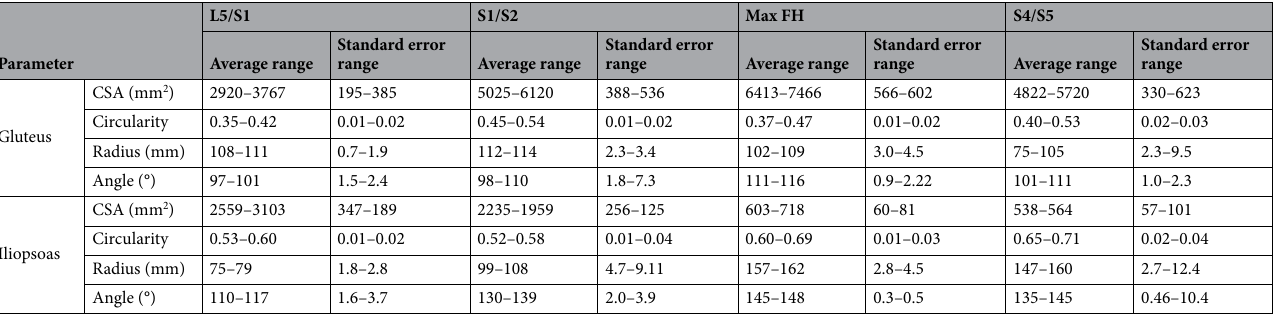
Table 3. Average muscle parameter